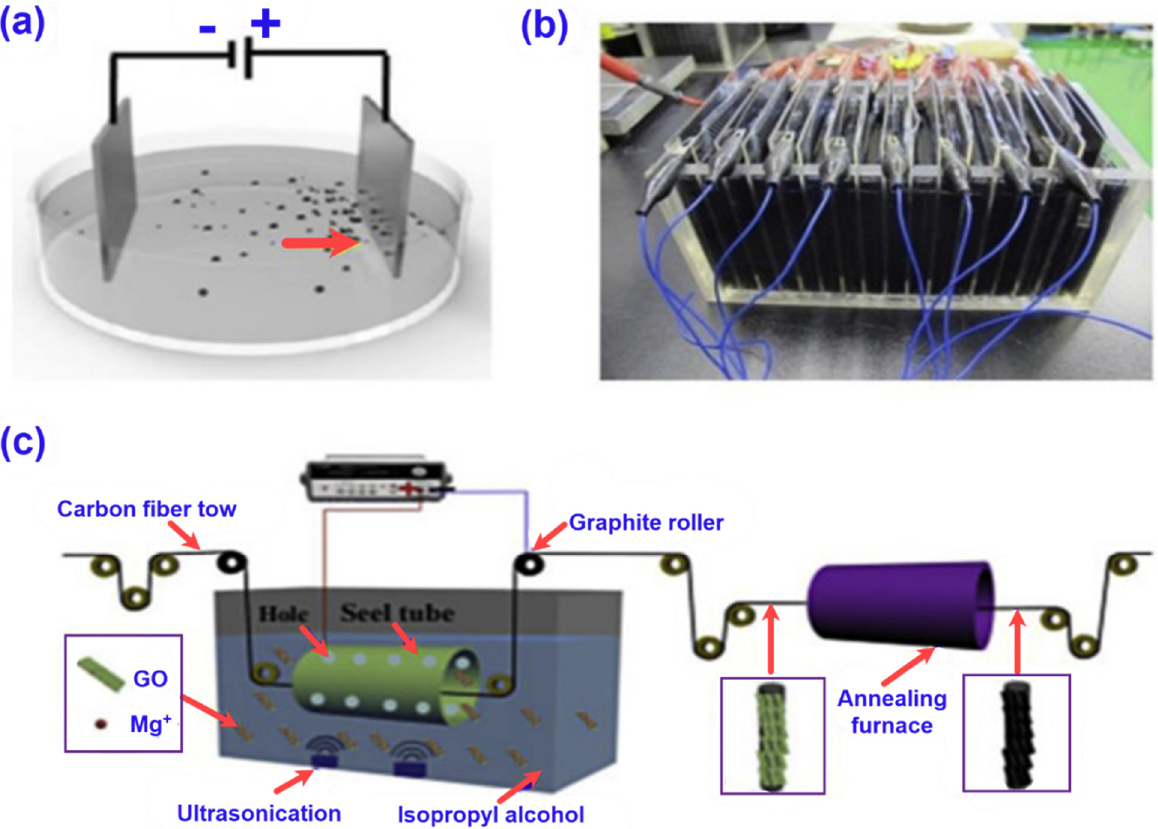
Figure 9. The schematic of depositing graphene or modified graphene on the reinforcement fibres by the EPD technique. ( a ) Typical EPD equipment for the deposition of GO with positive and negative electrodes aligned in parallel [170], ( b ) EPD equipment that can produce 16 pieces of GO/CNT coated carbon fabrics simultaneously [171], ( c ) Equipment of continuous EPD of graphene on carbon fibres [172]. All the figures were reprinted with permission.